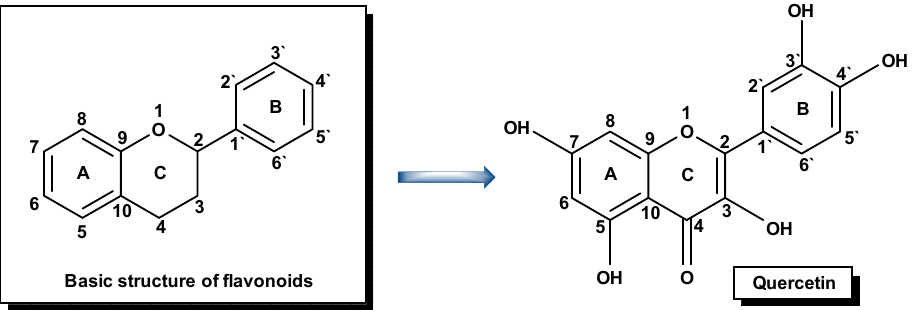
Figure 1. Basic skeleton of flavonoids and structure of quercetin.